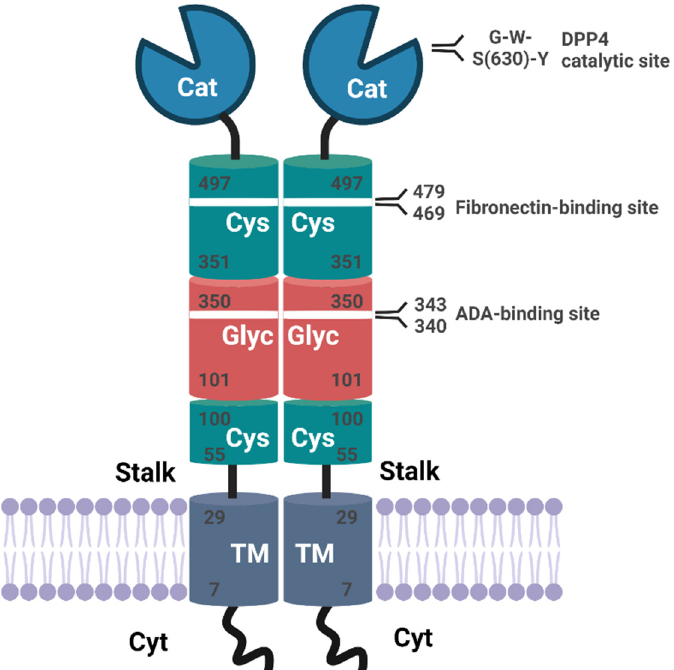
Figure 1. Schematic representation of DPP4 modular structure. Human CD26/DPP4 is a type 2 transmembrane serine protease comprising 766 amino acids (aa). The extracellular catalytic region (Cat, aa 506–766) with the catalytic triad H 740 , N 708 , and S 630 is located at the C-terminus followed by a cysteine-rich region (Cys, aa 351–497), a glycosylated region (Glyc, aa 101–350), another short cysteine-rich region (Cys, aa 55–100), and a flexible stalk region (aa 30-48). The transmembrane domain (TM) encompasses aa 17–29 and only 6 amino acids constitute the N-terminal cytosolic (Cyt) part of the molecule. The extracellular part contains binding sites for interaction partners like adenosine deaminase (aa 340–343) or fibronectin (aa 469–479). Full-length CD26/DPP4 is suggested to be cleaved within its flexible stalk region to release catalytically active soluble CD26/DPP4 (figure adapted from [1]).